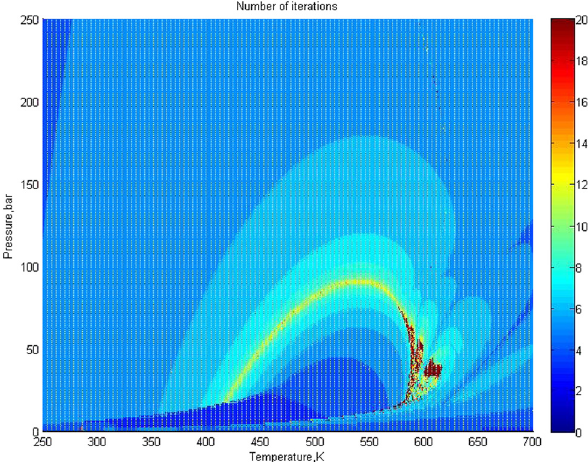
Figure 5: Number of iterations for the MY10 mixture, NBH method with type V initialization.